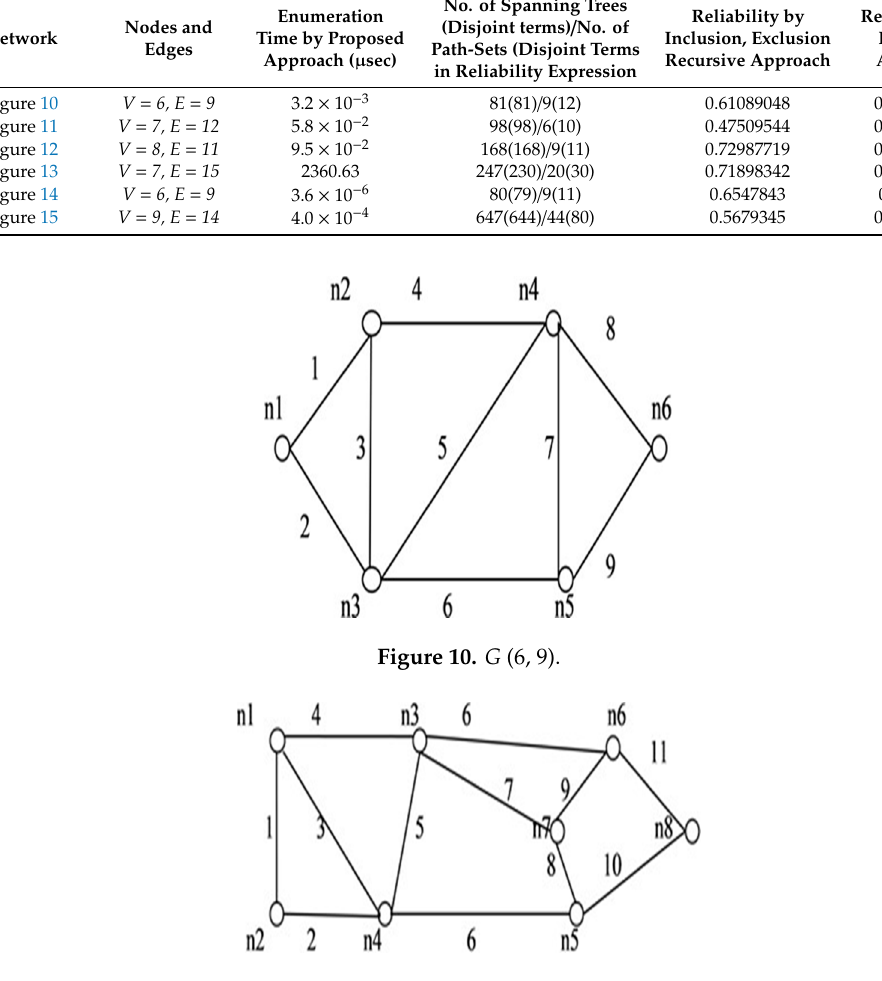
Figure 12. G (8, 11).